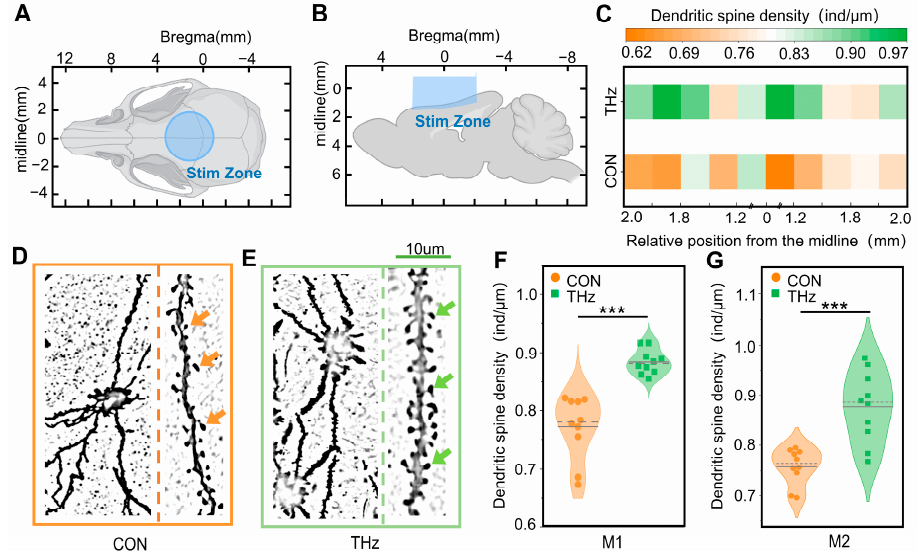
Figure 5. Teraher tz radiation promotes the growth of neuronal dendritic spines. ( A , B ) Teraher tz radiation to areas of the rat brains. ( C ) Patterns of dendritic spine density changes near the midline in coronal sections of rat brain tissue. ( D , E ) Golgi staining of neurons in the control (CON) and terahertz (THz) groups. ( F , G ) The cortical neuronal dendritic spine density was significantly higher in the rat cerebral cortexes (M1 and M2) than in the CON after 3 h of terahertz radiation. Data are mean ± SEM ( n = 10 independent experiments); *** p < 0.001 compared with CON, independent samples t -test.